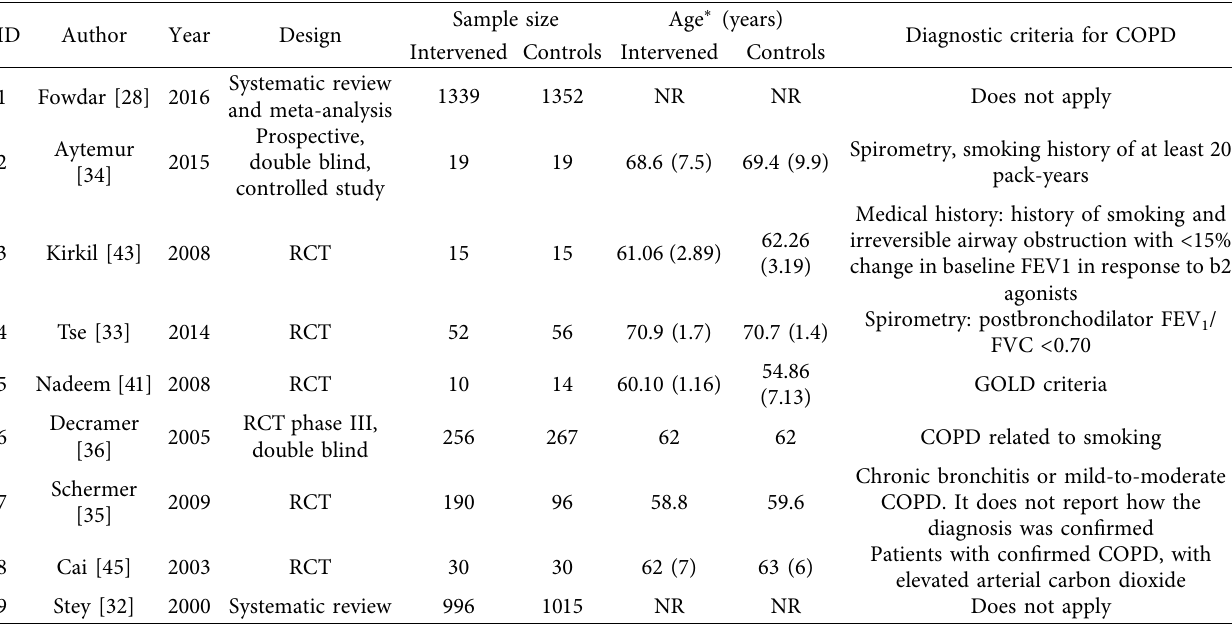
Figure 2: Flowchart for studies included in the scoping review. Table 1: Characteristics of the included